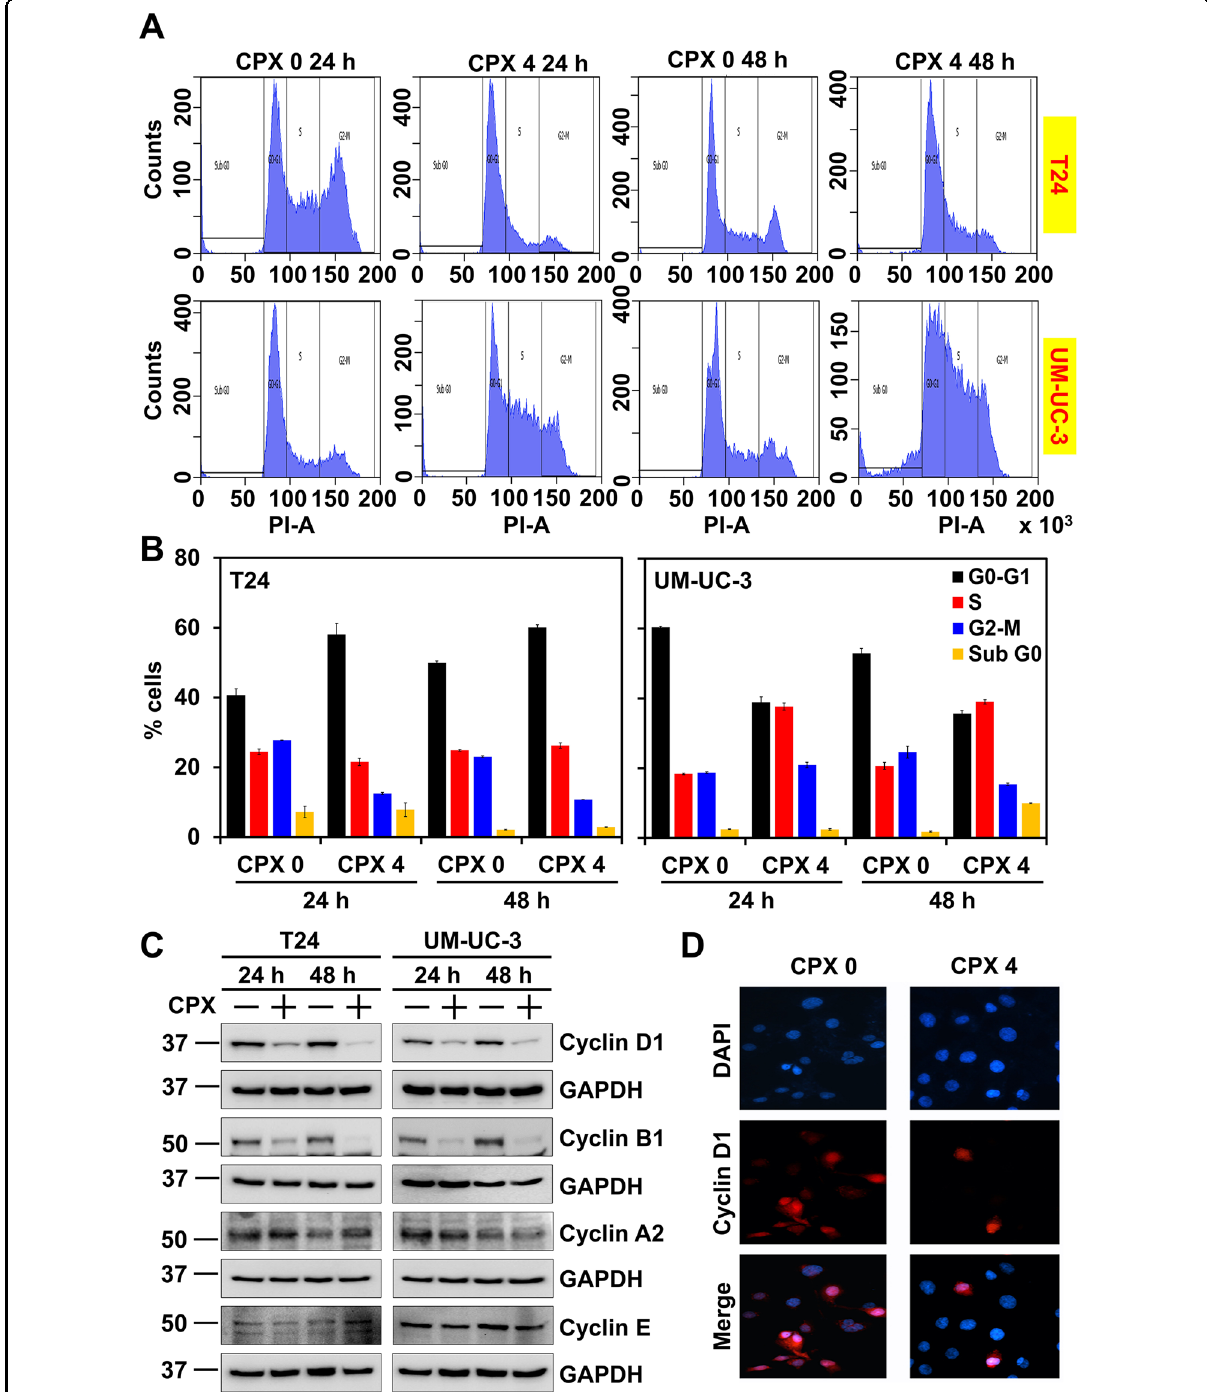
Fig. 2 CPX induces cell cycle arrest in bladder cancer cell lines. A Cell cycle analysis of CPX-treated cells. T24 and UM-UC-3 cells were treated with 4 µM concentrations of CPX, and examined by fl ow cytometry. CPX treatment-induced G0/G1 arrest in T24 cells and S-phase arrest in UM-UC-3 cells. The percent cells in each phase are presented graphically ( B ). C CPX downregulates cyclin D1 and B1 expression in T24 and UM-UC-3 cells as assessed by western blot. D Immuno fl uroscence analysis shows downregulation of cyclin D1 expression after CPX treatment in T24